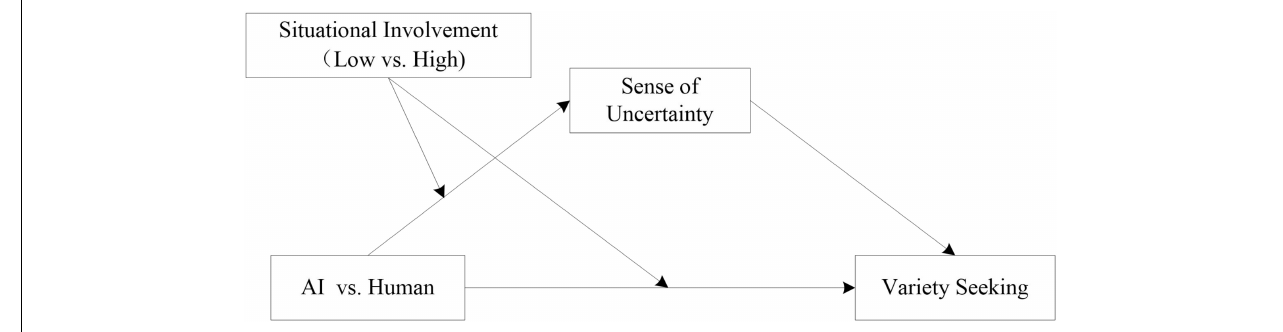
FIGURE 1 | Conceptual